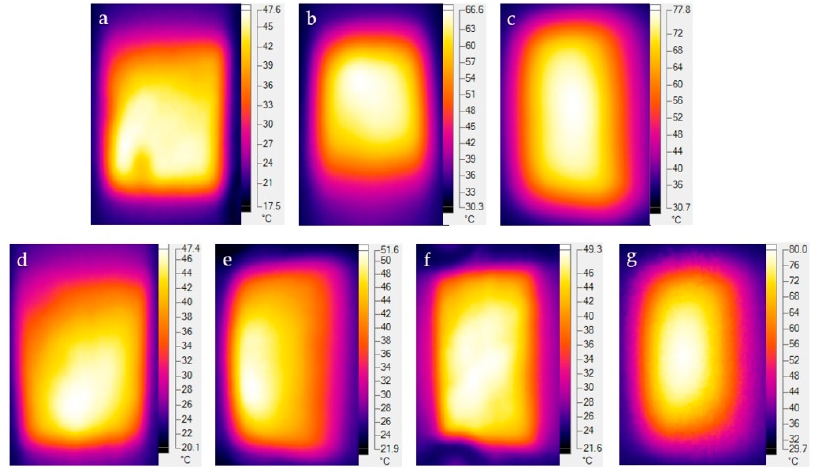
Figure 4. Infrared thermogram of CCGA prepared via various ultrasonic conditions of ( a ) 600 W, 40 min; ( b ) 800 W, 40 min; ( c ) 1000 W, 40 min; ( d ) 1000 W, 10 min; ( e ) 1000 W, 30 min; ( f ) 1000 W, 50 min; ( g ) 1000 W, 70 min.